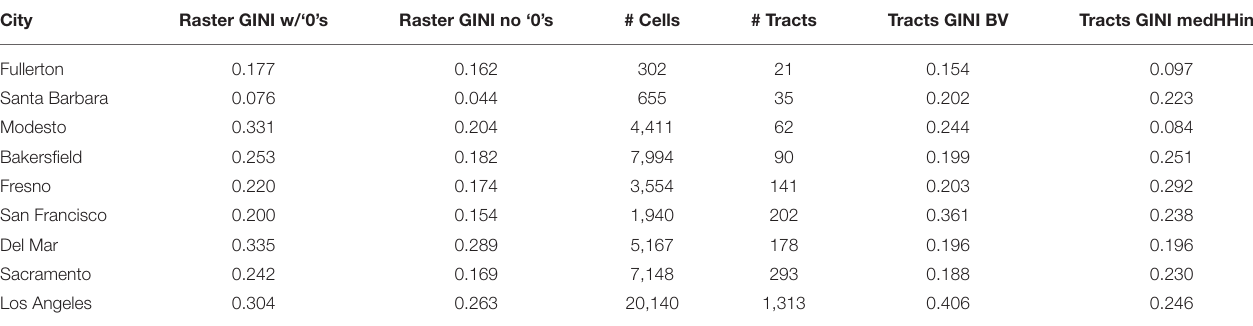
TABLE 2 | GINI coefficients of BV and Median Household Income. City Raster GINI w/‘0’s Raster GINI no ‘0’s # Cells # Tracts Tracts GINI